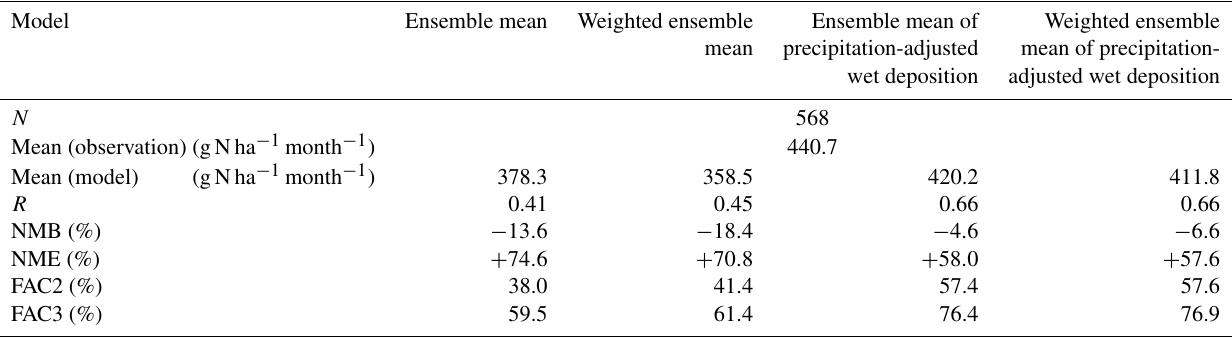
Table 8. Summary of the statistical analysis of model performance by ensemble and precipitation-adjusted approaches for the wet deposition of